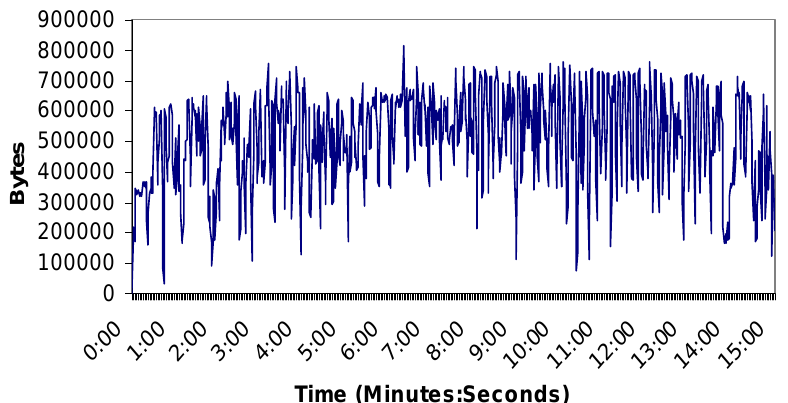
Figure 16. Number of bytes per